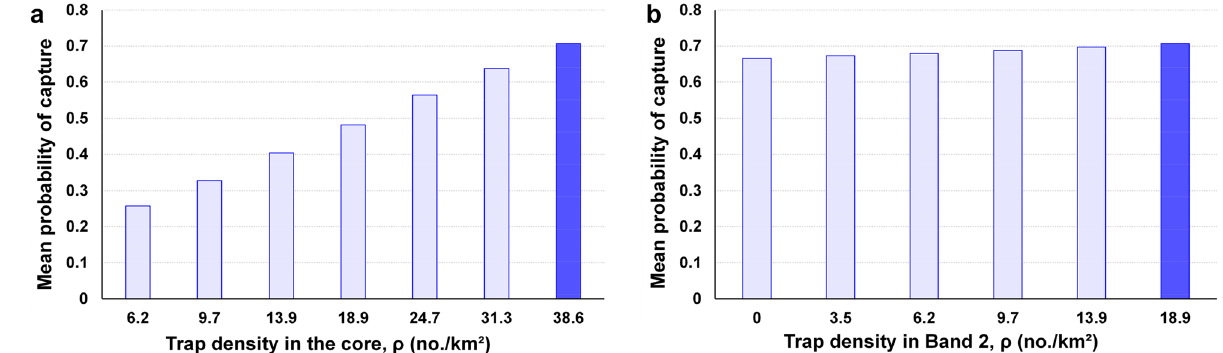
Figure 4. Probability of capture for the entire 14.5-km grid for Medfly across different trap densities in either ( a ) the core, or ( b ) Band 2. Densities in other bands were held constant at default values. Dark blue bars show default values for that